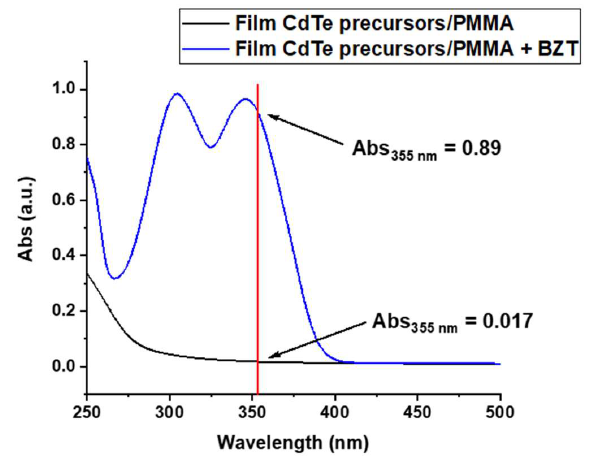
Figure 3. Absorption spectra of CdTe precursor film without BZT (black line) and with BZT (blue line. The different absorption at 355 nm is highlighted to emphasize the role of the BZT within the film.